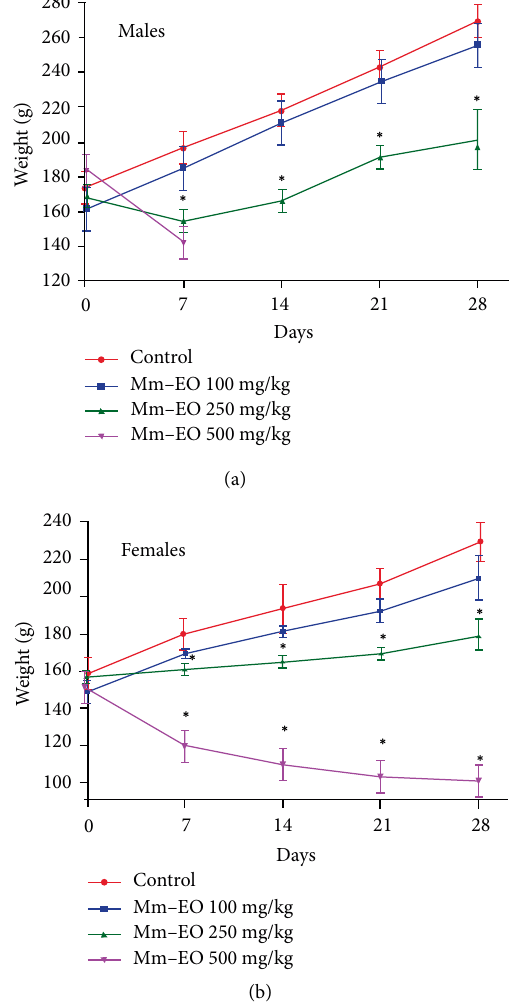
Figure 2: Body weight in rats treated with Minthostachys mollis essential oil (Mm-EO) repeated oral doses (100, 250, and 500 mg/ kg) for 28 days. ∗ 𝑝 < 0.05 compared to the